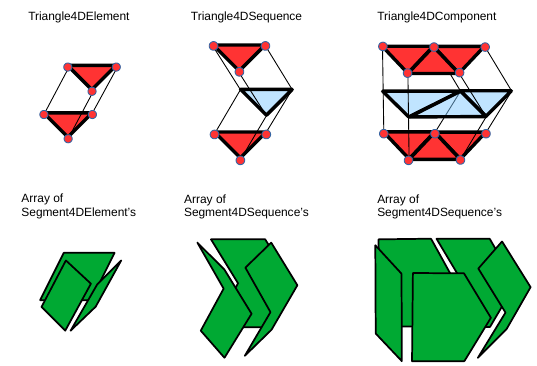
Figure 2. Three Surface4D aggregation levels and their border objects (red and green)